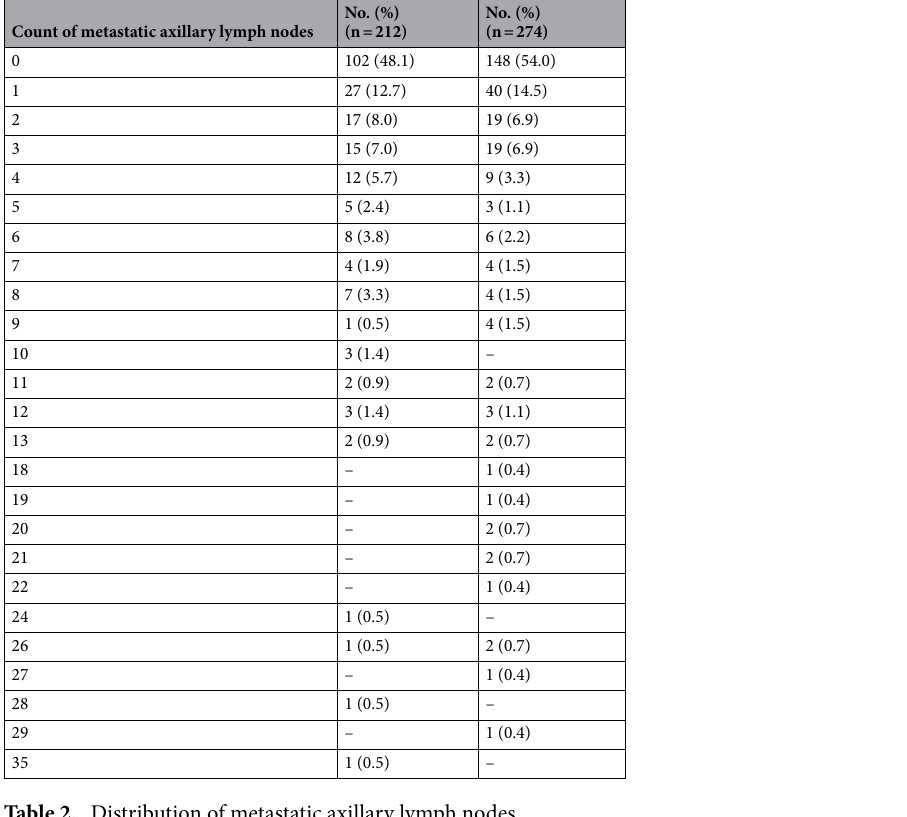
Count of metastatic axillary lymph nodes